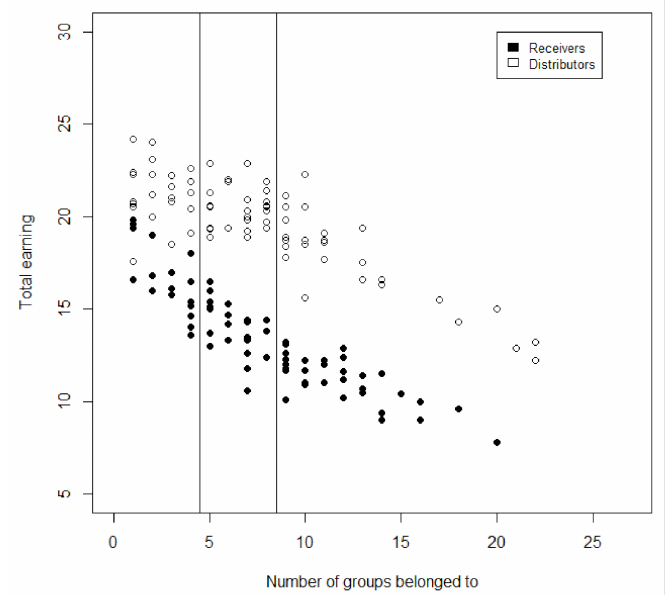
Figure 6. Total earnings in Euros of individual distributors and receivers, given the number of groups they belonged to. The vertical lines divide subjects into three sub-groups of roughly equal size: “few-group” subjects, i.e., subjects belonging to 4 groups or less, “multi-group” subjects belonging to 9 groups or more, and “some-group” subjects belonging to a medium number of different